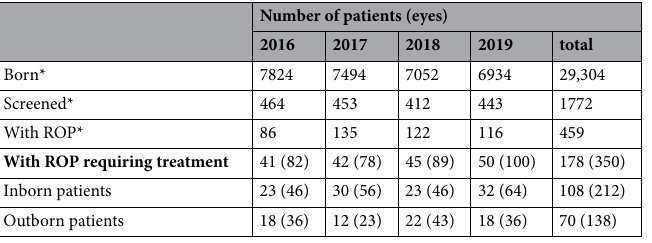
Table 1. Data on the number of patients/eyes in particular years. *Data for inborn